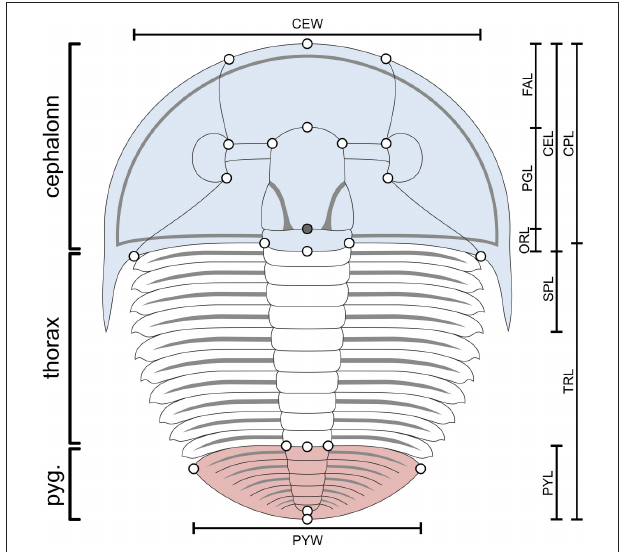
FIGURE 3 | Aulacopleura koninckii dorsal morphology. Colors highlight the three main body regions in trilobites: cephalon, blue; thorax, white; pygidium, red. Bars show the main morphometric characters used for ontogeny reconstruction herein (see Supplementary Appendix). CEL, cephalic axial length; CPL, cephalic paraxial length; CEW, cephalic width; FAL, frontal area length; PGL, preoccipital glabellar length; ORL, occipital ring length; SPL, genal spine length; TRL, trunk length; PYL, pygidial length; PYL, pygidial width. Empty circles are the position of the 22 landmarks used in the study of allometry (see Hong et al., 2014). The filled circle is the position of an additional landmark used for measuring the two most posterior sections of the cephalon (PGL and ORL). Landmarks used for measuring the length of each thoracic segment (TSL) are not shown (see text and Fusco et al., 2016). The number of thoracic segments varies among specimens (a stage s 10 meraspid specimen, with 10 thoracic segments, is illustrated here).